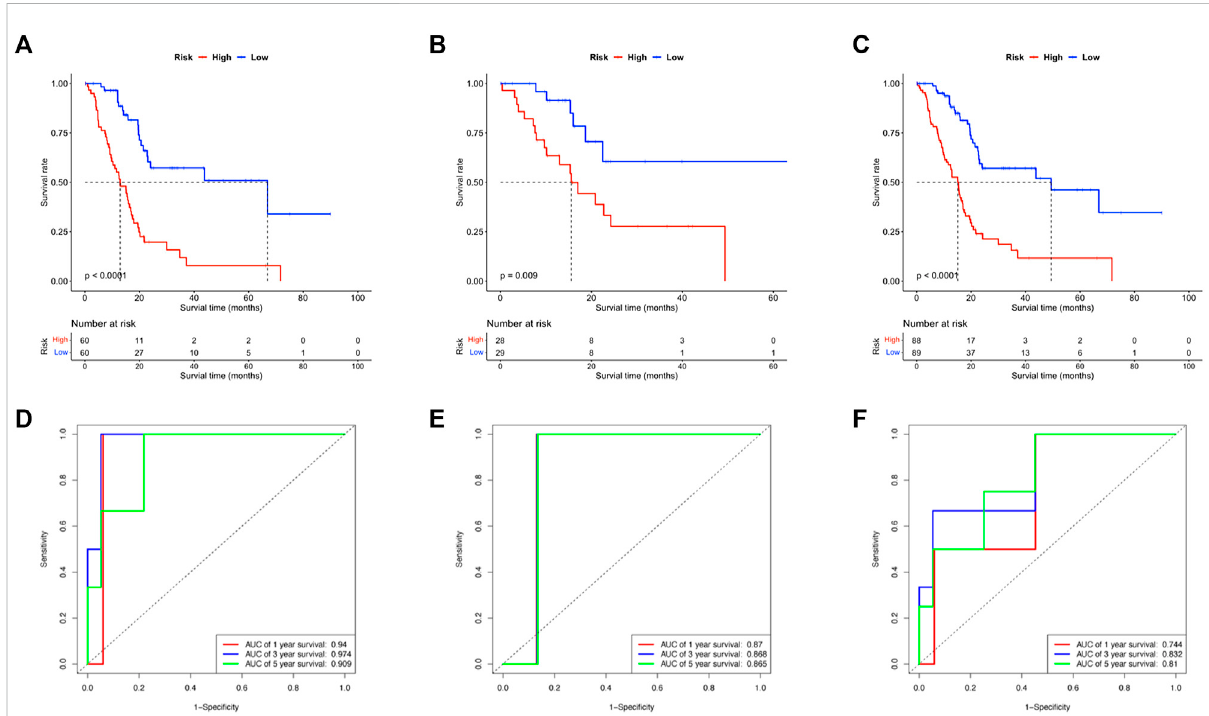
FIGURE 3 Evaluation of the ef fi cacy of lncRNA based signature. (A – C) The Kaplan-Meier survival curves compared the patients in high- and low-risk subgroups of all training, testing and whole cohorts. (D – F) The ROC curve anticipated the 1, 3, and 5 years survival of patients in all training, testing and whole